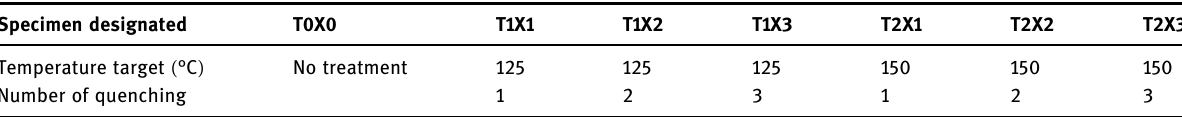
Table 3: Specimen identi fi cation for testing